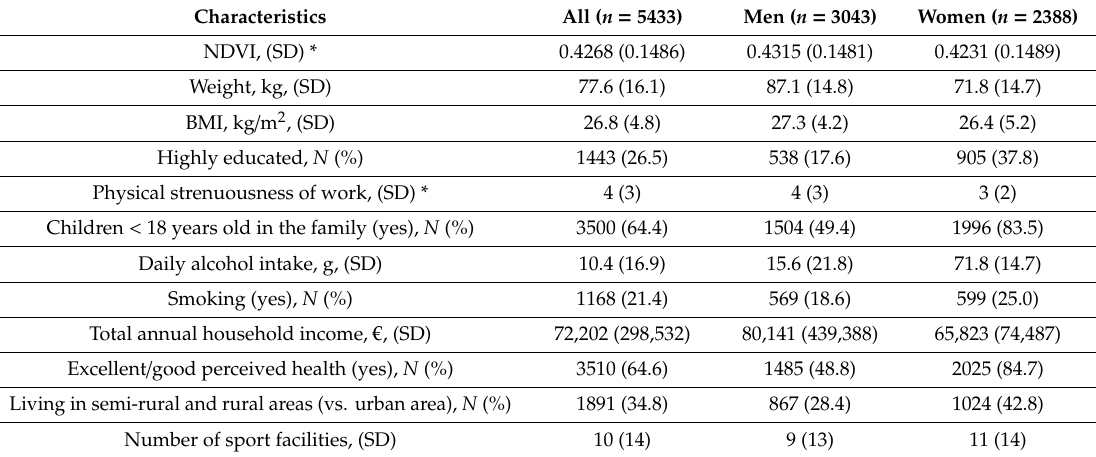
Table 1. Characteristics of the study